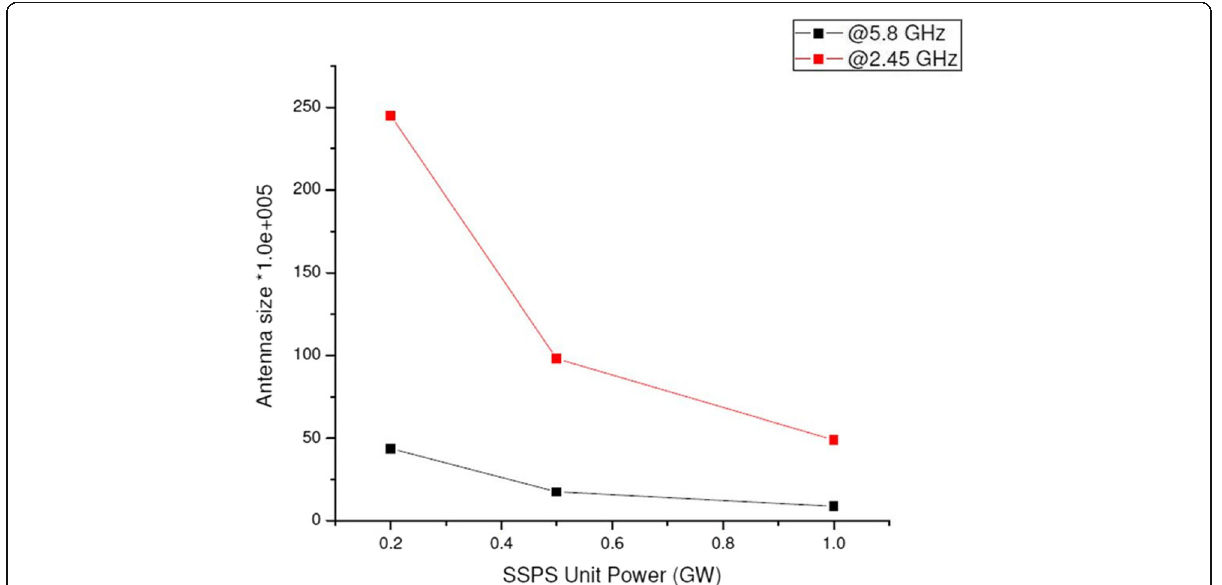
Fig. 10 Antenna size (m 2 ) variation with different GW power